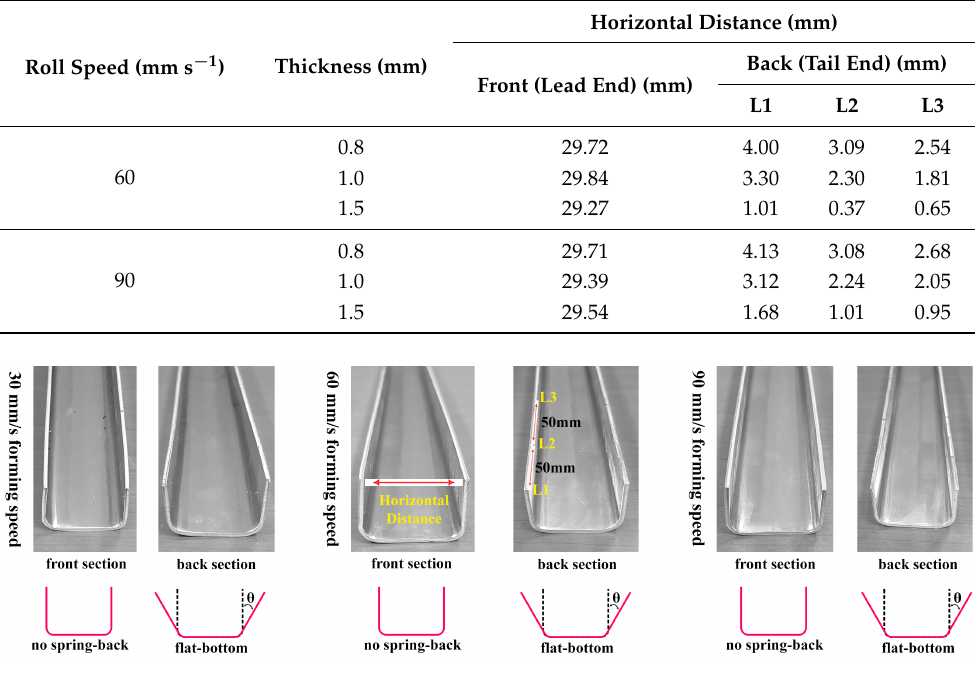
Figure 9. Section views of formed short U-profiles at different forming